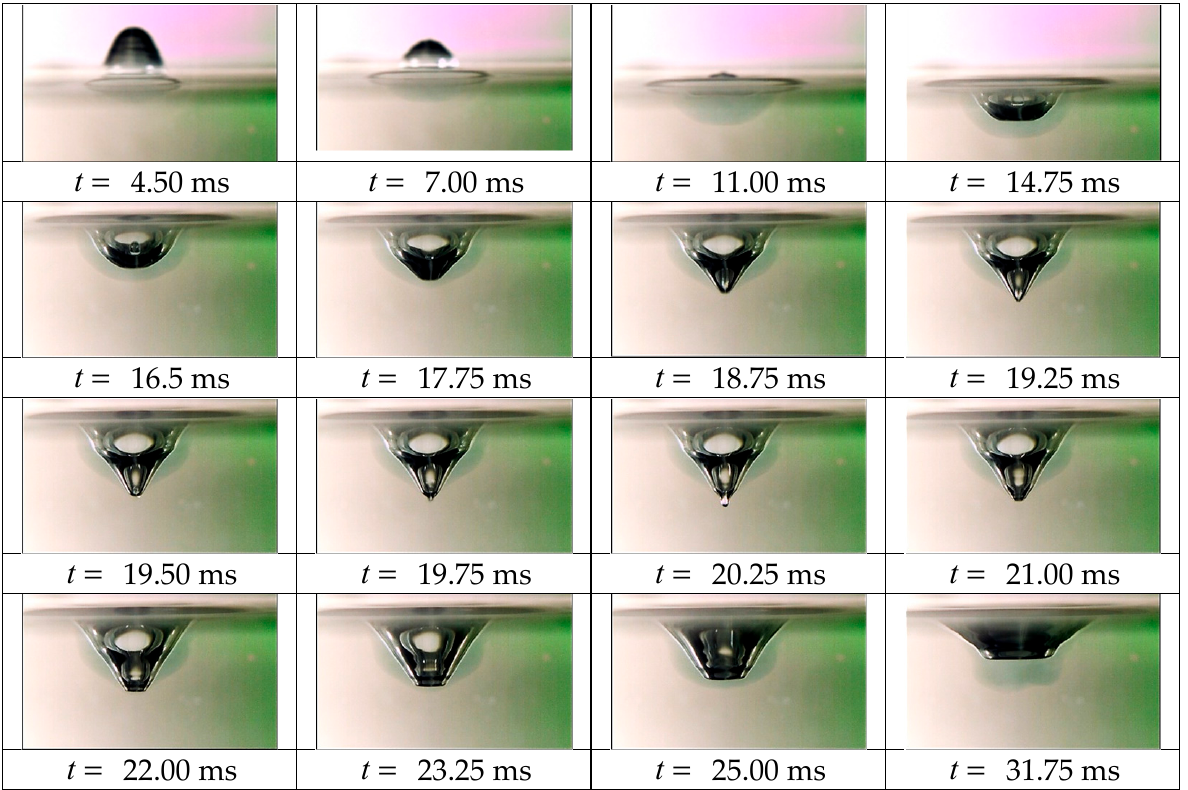
Figure 4. Side view of the flow produced by slow falling drop of an aqueous ink solution diluted at ratio 1:2500 coalescing with tap water ( D = 4.3 mm, U = 0.34 m/c, E σ = 4 mkJ, E k = 2.24 mkJ, Re = 1460, Fr = 2.8, We = 6.7, Bo = 2.5, Oh = 0.0018, R E = E k / E σ = 0.57, R w = 7.8 × 10 − 7